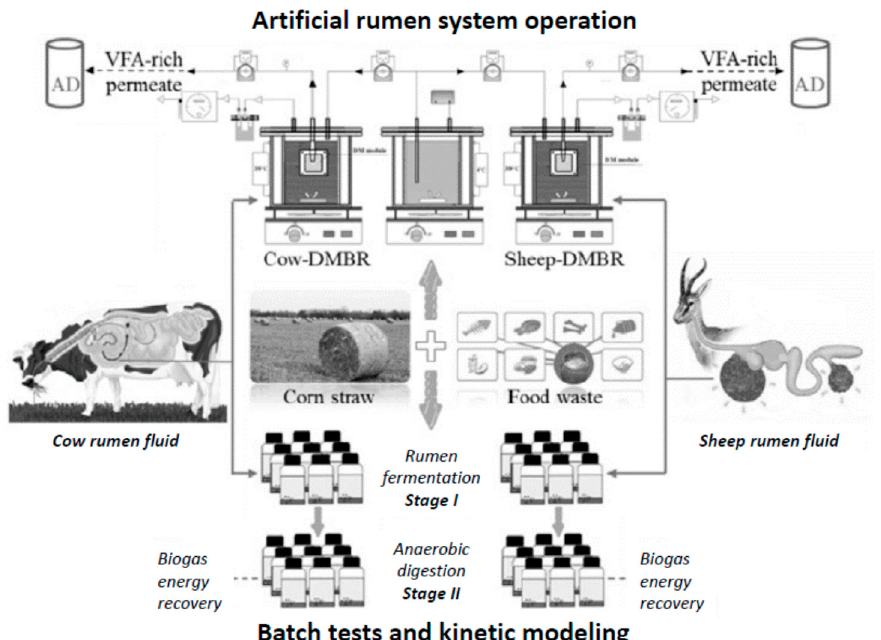
Figure 6. Artificial cow rumen system as a promising way to degrade lignocellulosis biomas recycling methane emissions and allowing a better characterization of ruminal population (from: Xing et al. [17]. Abbreviations: VFA: Volatile Fatty Acids; AD: anaerobic digestion; DMBR: dynamic membrane biorreactor.).